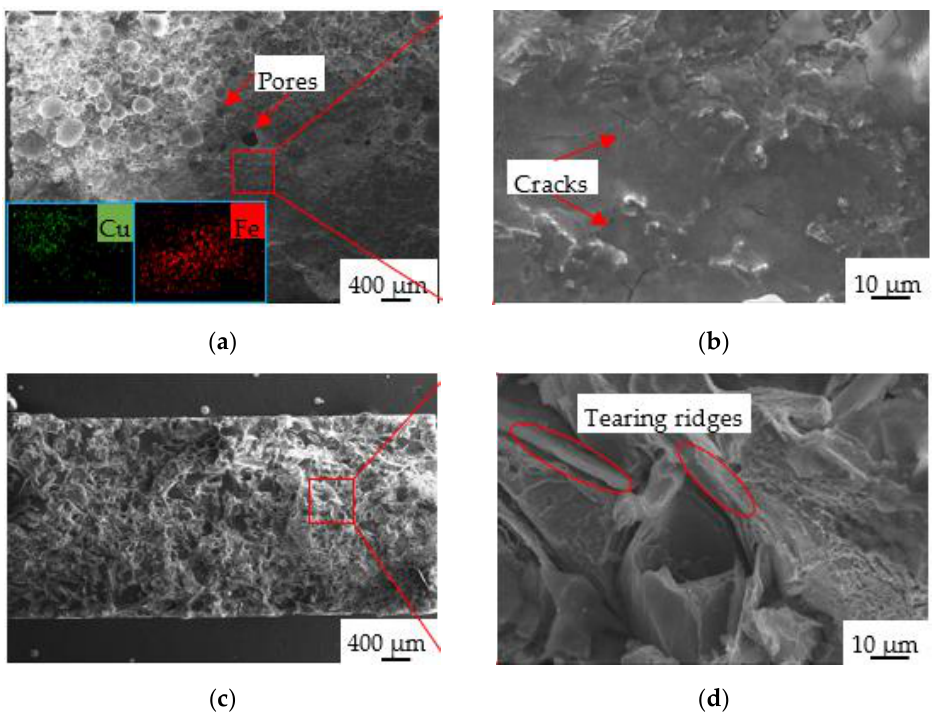
Figure 11. Fracture morphology of tensile samples without interlayer ( a , b ) and with the Inconel 718 interlayer ( c , d